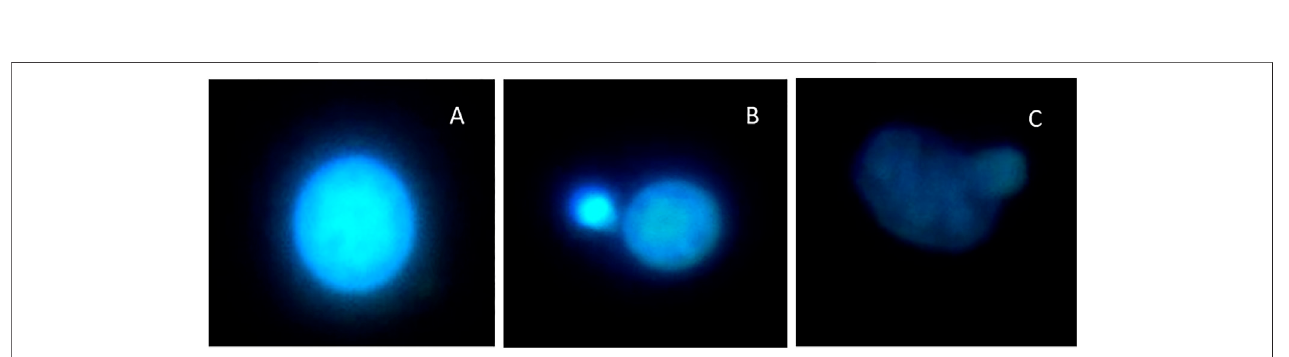
FIGURE5| Chromosomal aberrationsand micronuclei in R.philippinarum haemocytesfollowing exposure to antibiotics and their mixture. (A) Normal nucleus. (B) Micronucleus. (C) Multipolar cell.